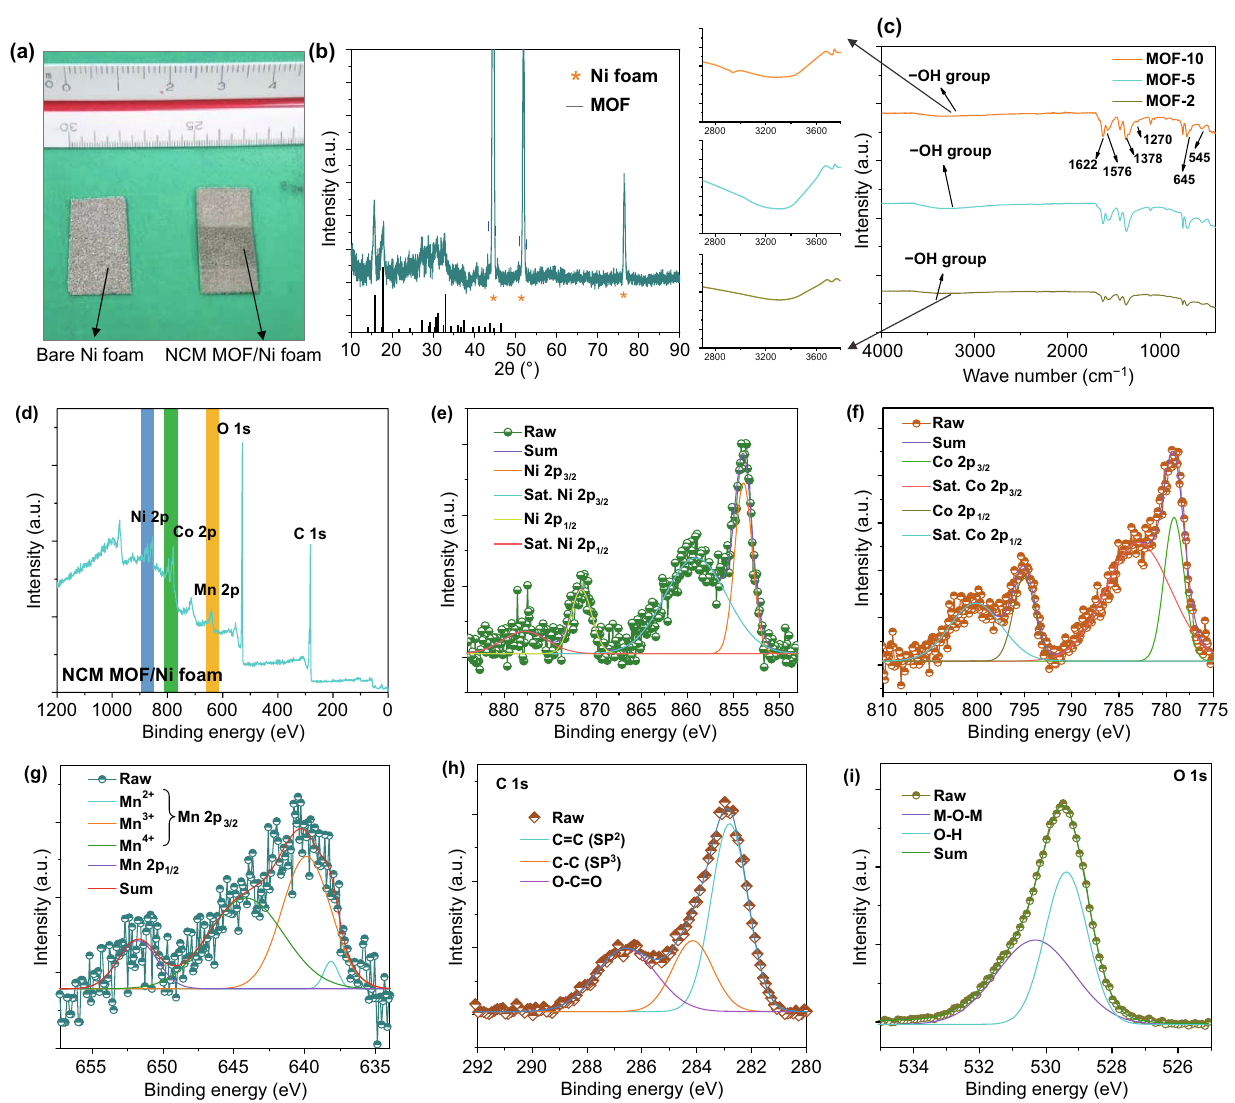
Fig. 3 a Photographic image of the prepared samples, b XRD pattern of NCM-based MOF-5/Ni foam, c FT-IR spectra of MOF-NCM-based samples synthesized for various growth times. d XPS survey scan spectrum and high-resolution XPS spectra of e Ni 2 p , f Co 2 p , g Mn 2 p , h C 1 s and i O 1 s of the dual-layered NCM-based MOF